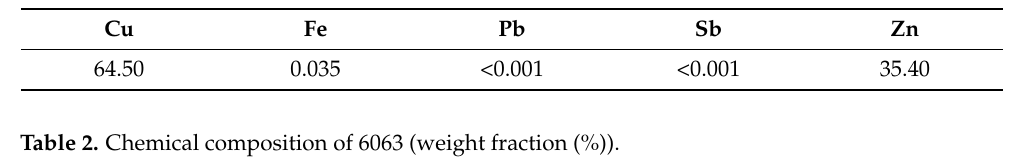
Table 2. Chemical composition of 6063 (weight fraction (%)). Mg Table 1. Chemical composition of H65 (weight fraction (%)). Table 3. Main mechanical characteristics of materials at room